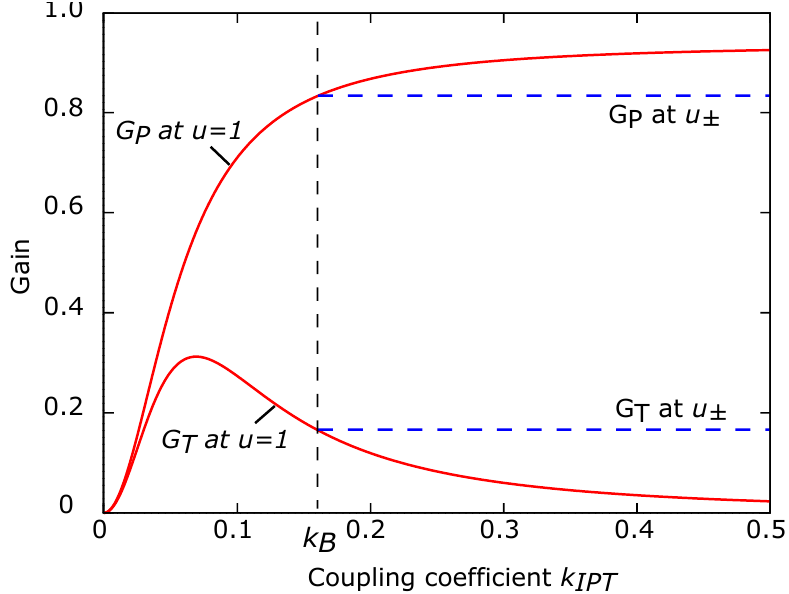
Figure 5. The continuous lines show the gains G P , IPT and G T , IPT at the main resonant frequency u = 1 as function of the coupling coefficient k IPT for the example IPT configuration. The dashed lines indicate the values at the secondary resonant frequencies u ± , valid for k IPT > k B